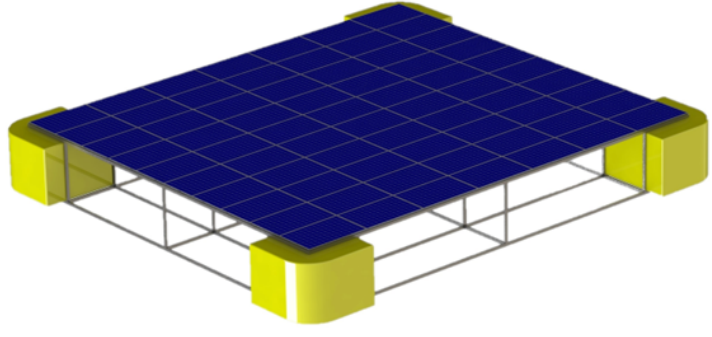
Figure 3. Schematic of a FPV panel from class